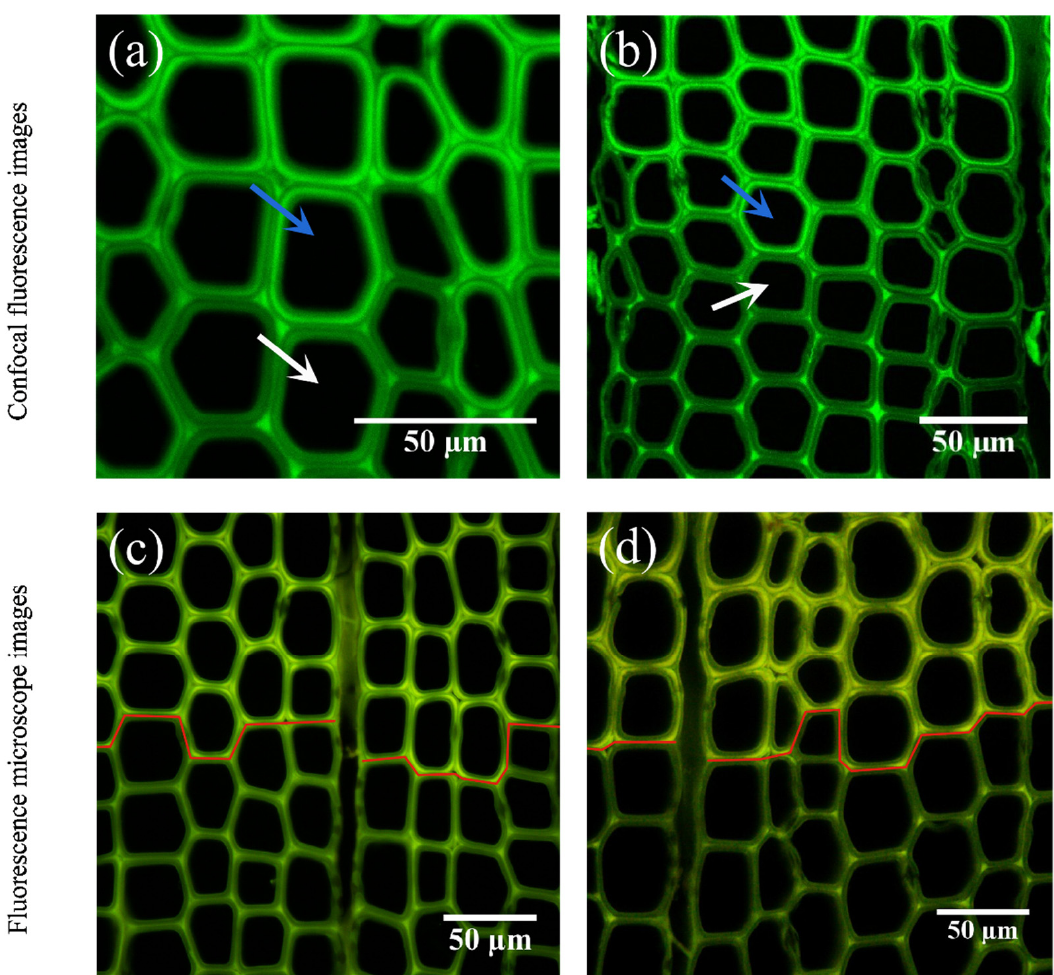
Figure 8. Lignin distribution in the cell walls of TA tracheids. The blue arrow points to the compressed tracheids, the white arrow points to the normal tracheids and the red line represents the demarcation line between normal and compressed tracheids. ( a , b ): confocal fluorescence images; ( c , d ): fluorescence microscope image.